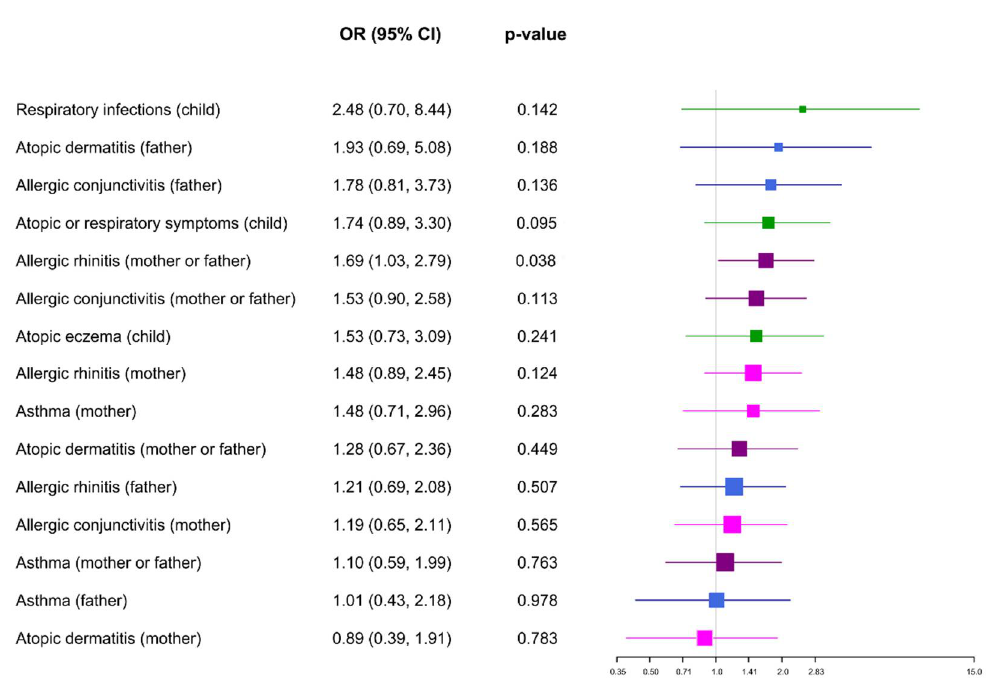
Figure 1. Dampness and atopic disorders. Odds ratios (ORs) and their 95% confidence intervals (CI) that show the risk of suffering an atopic disease related to indoor dampness.